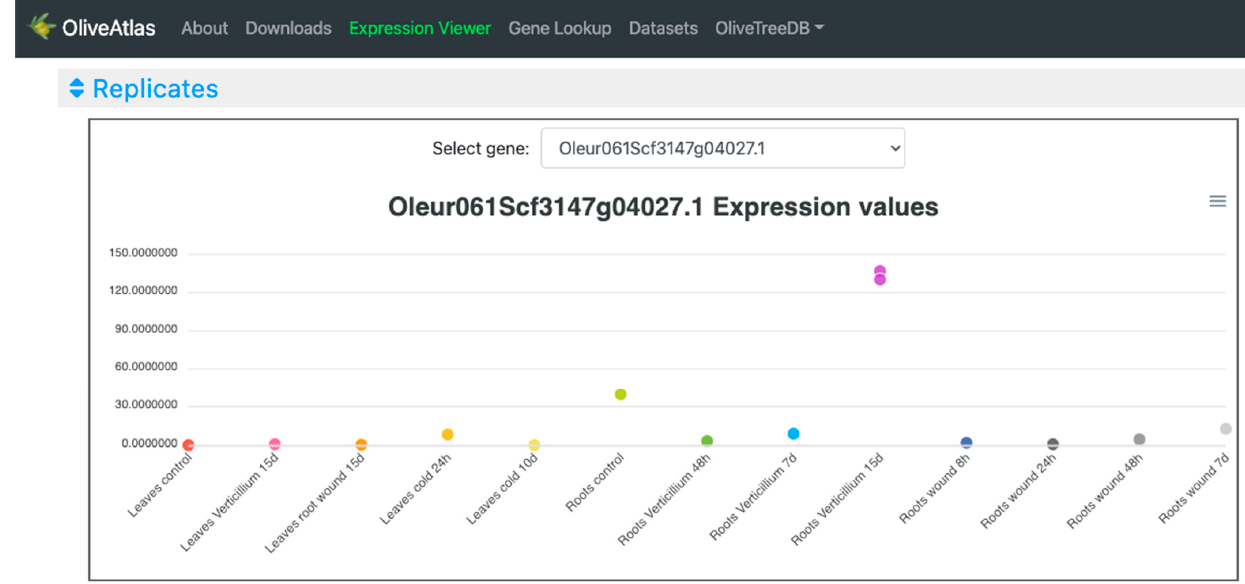
Figure 7. Expression values of replicates of an example gene in the “Expression viewer” tool of OliveAtlas.